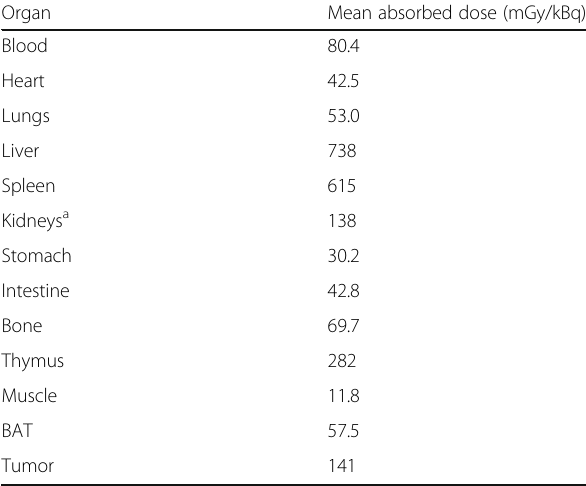
Table 2 Mean absorbed doses to normal organs and tumor for